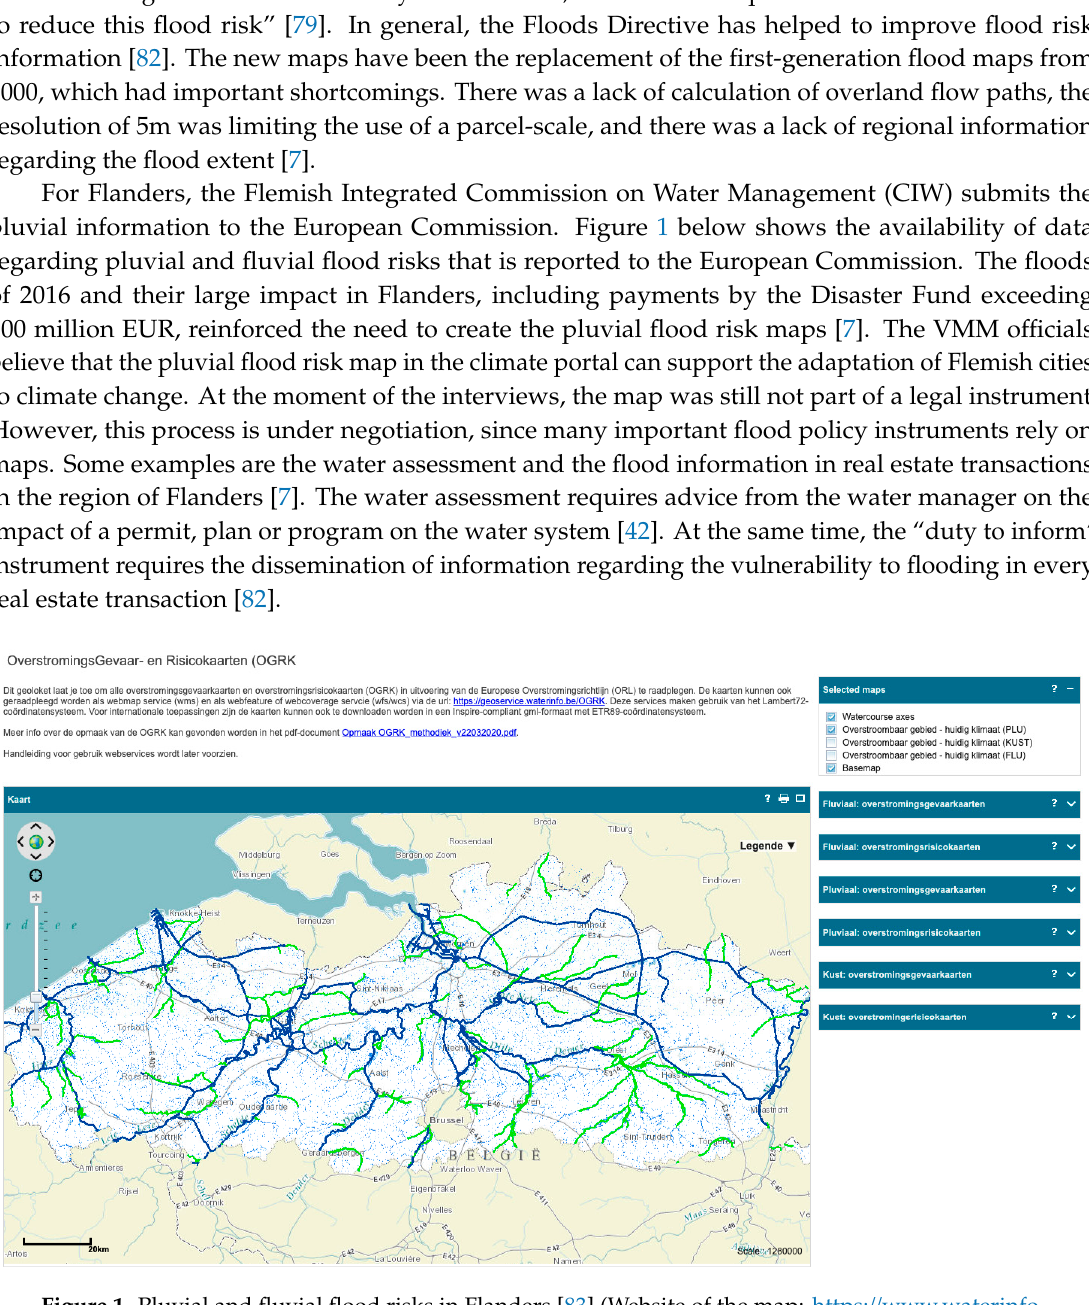
Figure 1. Pluvial and fluvial flood risks in Flanders [83] (Website of the map: https: // www.waterinfo. be /